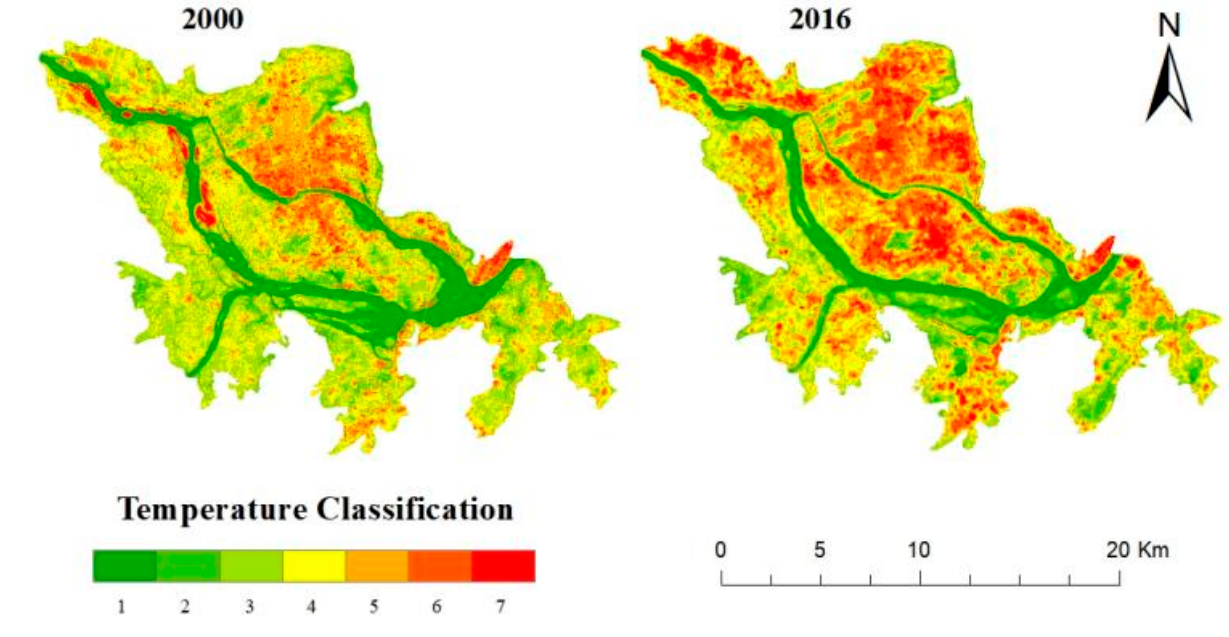
Figure 4. Classification of urban heat islands in 2000 and 2016.